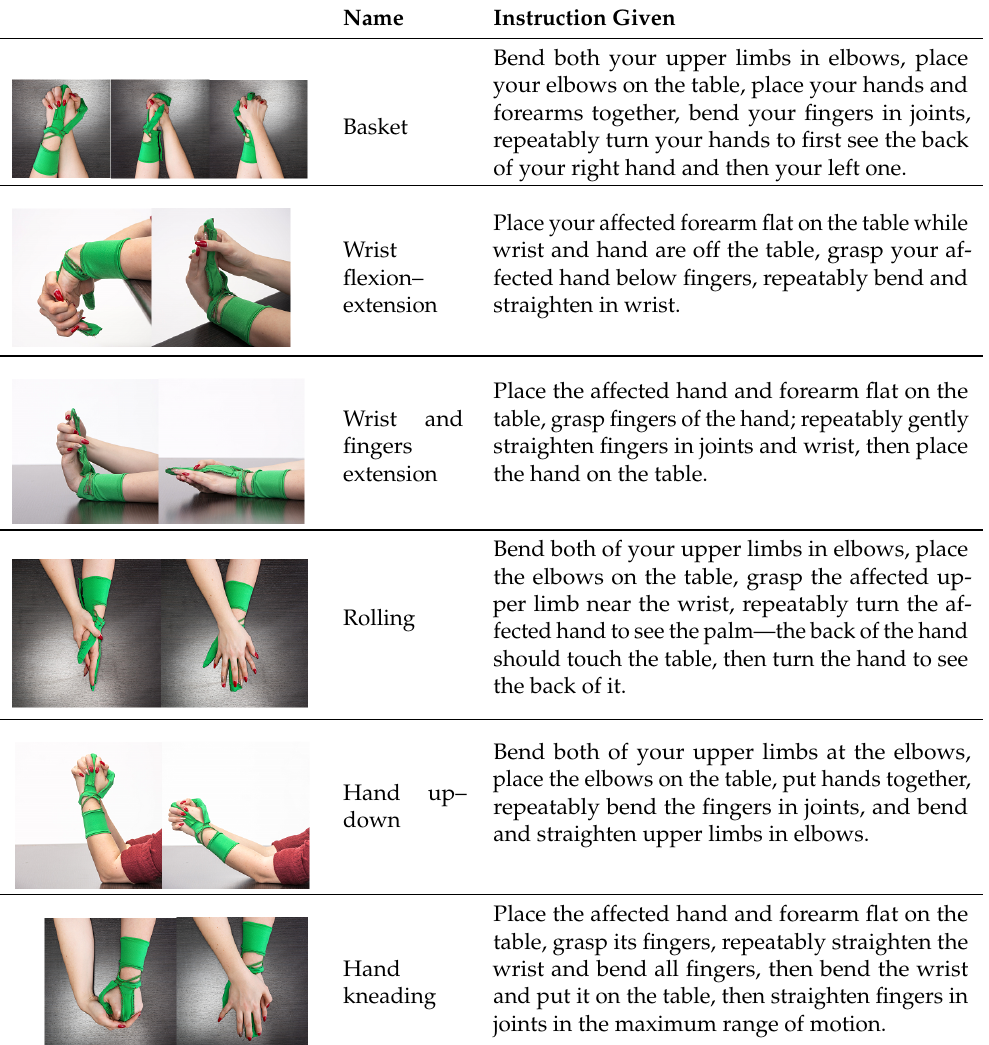
Table 1. Joint mobility exercises shown through the Przypominajka interface. The exercises are also classes that the categorizer can recognize.